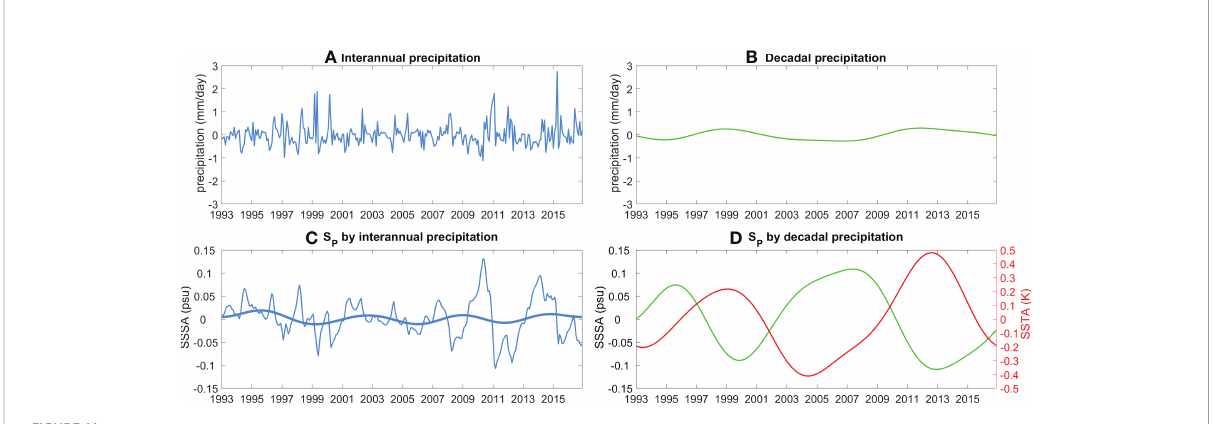
interannual and decadal precipitation anomalies, respectively. The thick curve in (C) denotes the 6-year low-passed S p . The red curve in (D) denotes the NNI (in